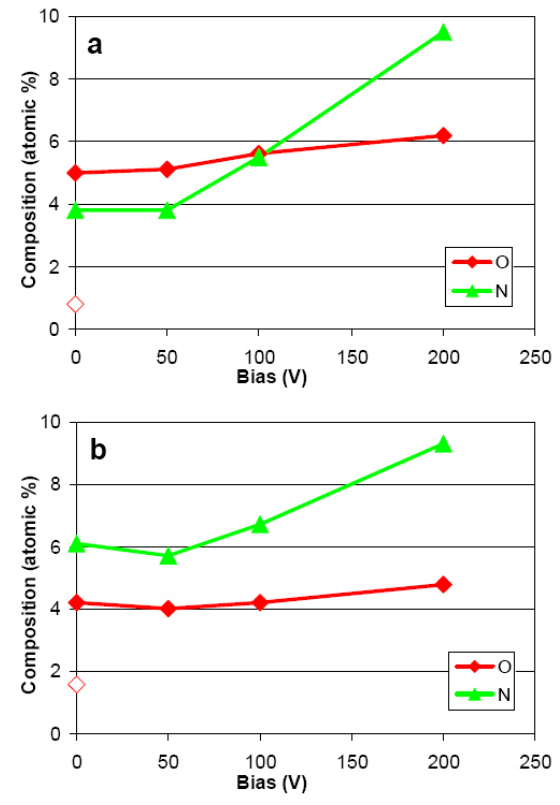
Figure 1: The surface composition of the HOPG (a) and GR (b) samples, treated for 10 min, as the function of the applied bias. Open symbols represent untreated samples.